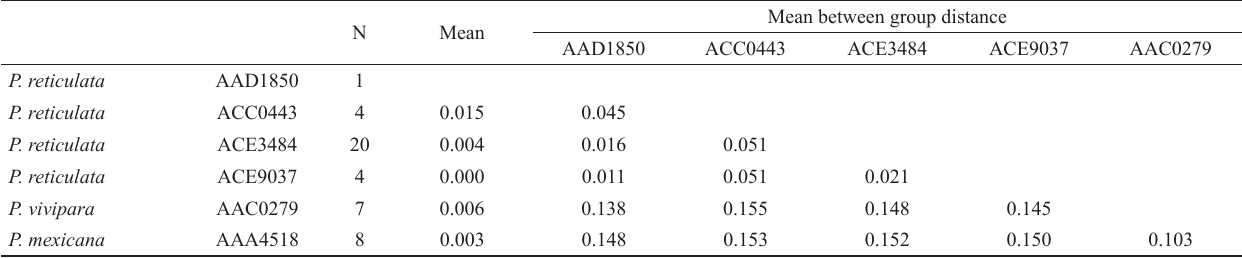
Tab. 3. Summary of genetic distances among BINs of Poecilia reticulata and both species of Poecilia utilized as outgroups. Mean: mean within group